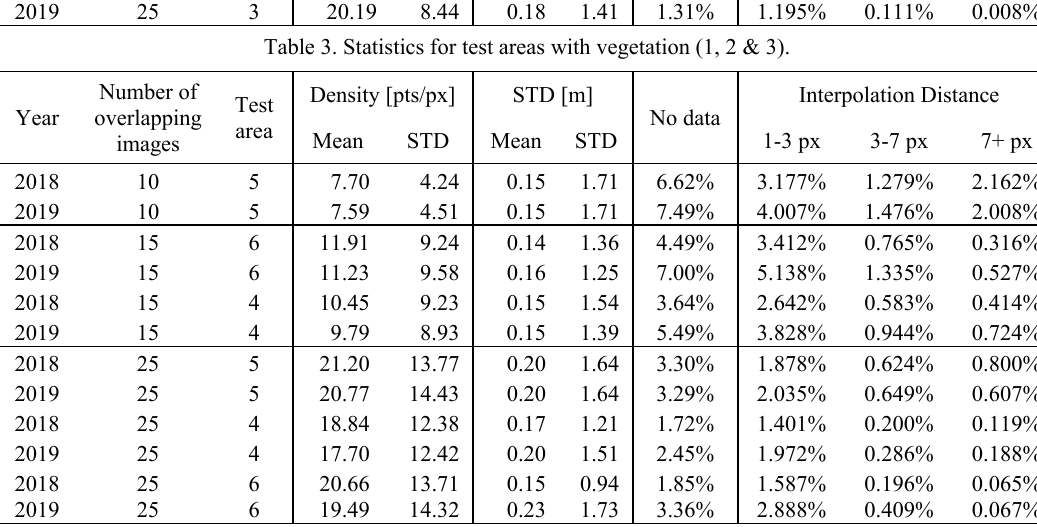
Table 3. Statistics for test areas with vegetation (1, 2 & 3).